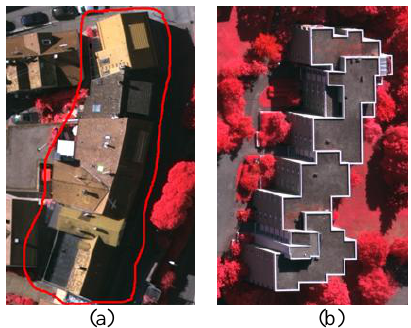
Figure 6. Profile of roof in Figure 5